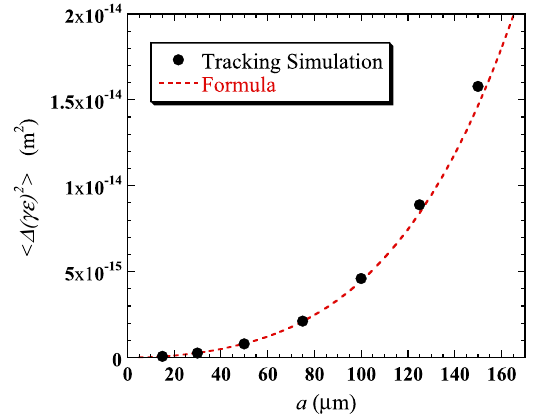
FIG. 5. Average growth of square of emittance [ hð (cid:4)(cid:3) Þ 2 i ] at the linac end after one to one correction as a function of BPM offset error (rms). Results of tracking simulation (circle), and the analytic